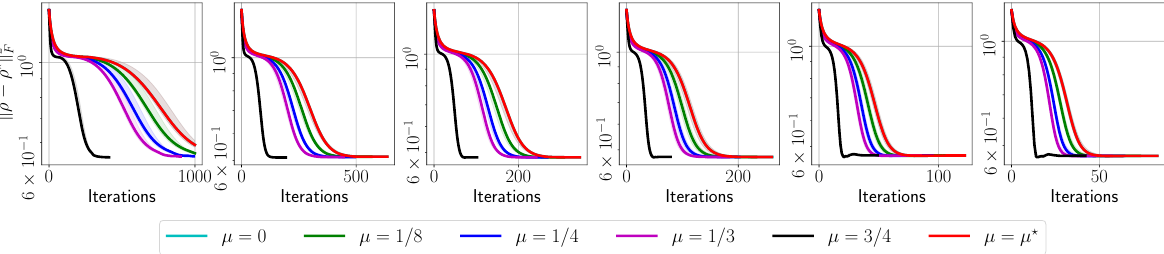
( 8 ) circuit using real measurements from −